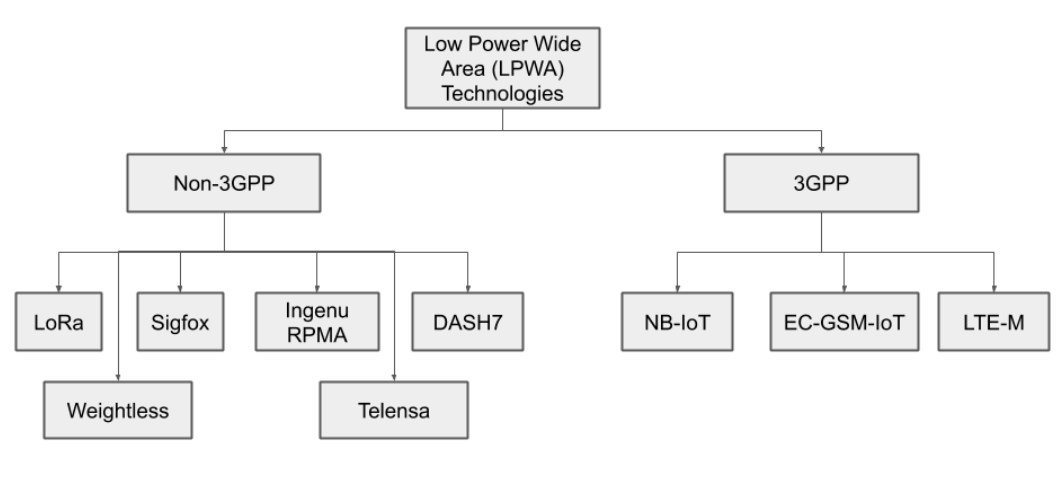
Figure 1. Low Power Wide Area Network